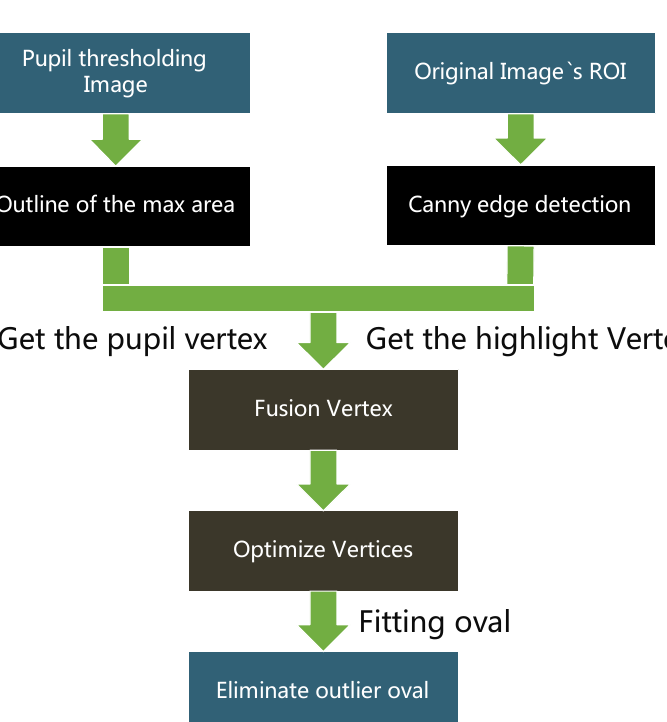
Figure 33. Flowchart for fitting the pupil ellipse [10].